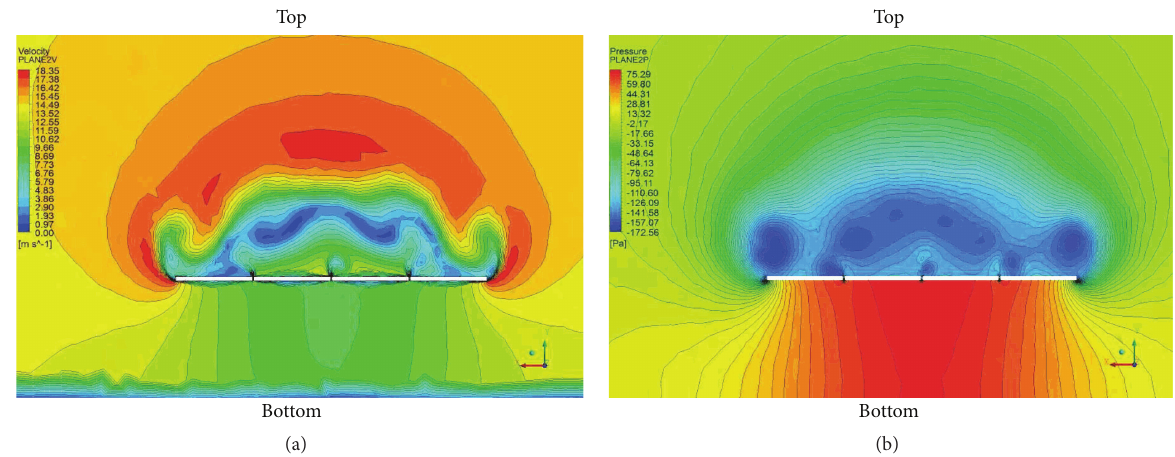
Figure 15: (a) Velocity magnitude (m/s) and (b) static pressure (N/m 2 ) contours at conventional panels, Section 2 , Figure 12, wind from bottom to top.